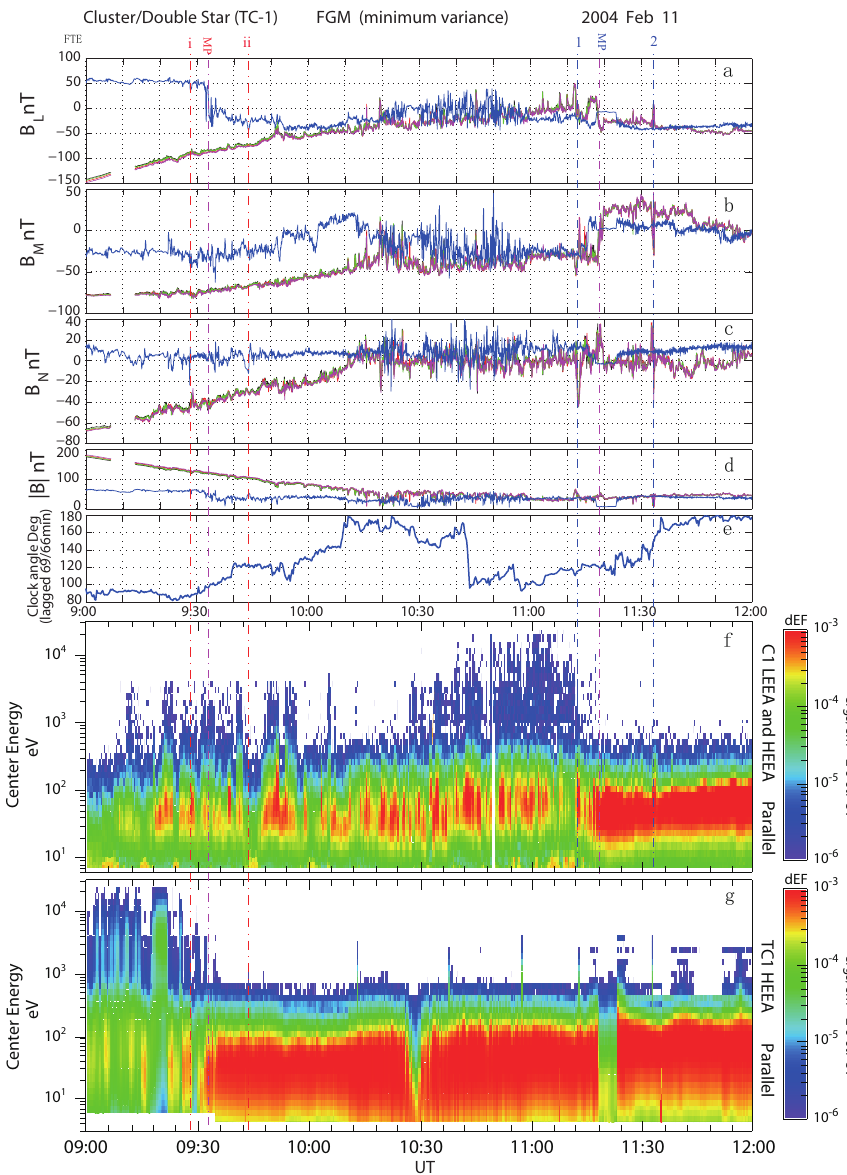
Fig. 3. An overview of the FGM measurements which are projected onto a LMN coordinates, and the lagged IMF clock angle, together with the spectrograms of electron field-aligned differential energy flux from the HEEA and LEEA sensor of PEACE on the Cluster S/C 1 and from PEACE instrument on TC-1, between 09:00 and 12:00UT on 11 February 2004. Here highlight two FTEs observed by TC-1 by red dashed vertical lines, and two FTEs measured by Cluster by blue dashed vertical lines, respectively. There also marked the magnetopause crossing at about 09:33UT for TC-1 and about 11:18UT for Cluster by violet dashed vertical lines.